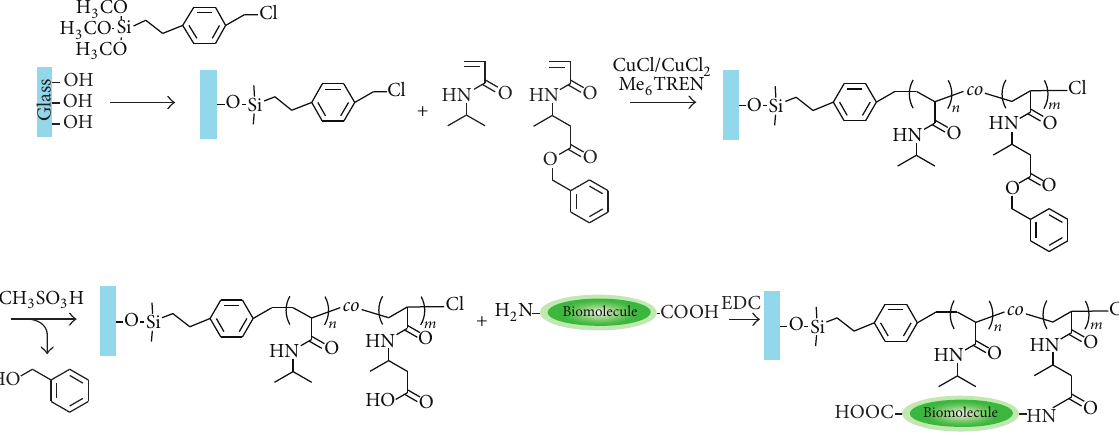
Figure 2: Fabrication scheme for the poly(NIPAAm- co -CIPAAm) graft and biomolecule